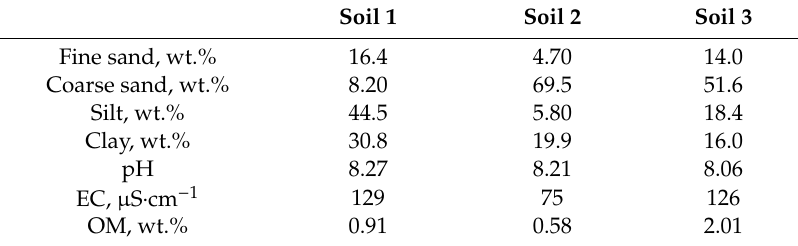
Table 3. Physical-chemical properties of the studied Mediterranean soils. Soil